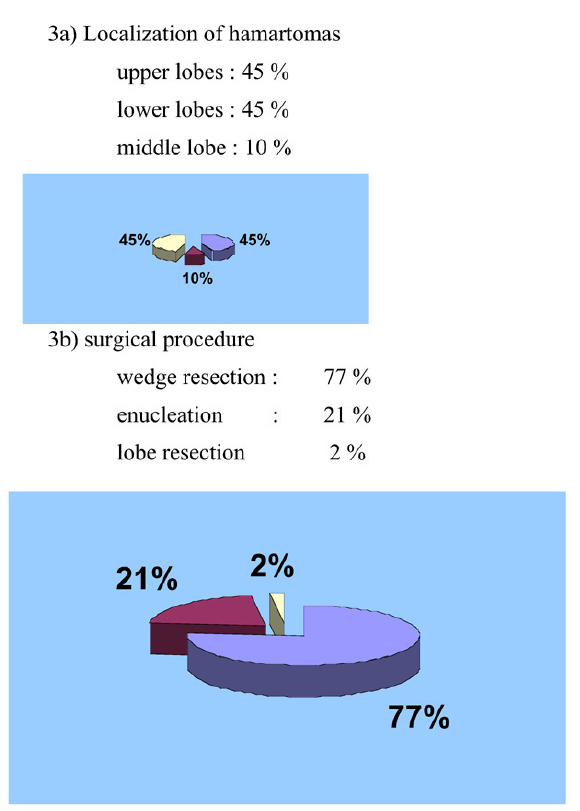
FIGURE 3. Localization of pulmonary hamartomas ( a ) and surgical procedures ( b ). a: hamartomas of the upper lobes, 45%; lower lobes, 45%; middle lobe, 10%. b: wedge resection, 77%; enucleation, 21%; lobe resection,